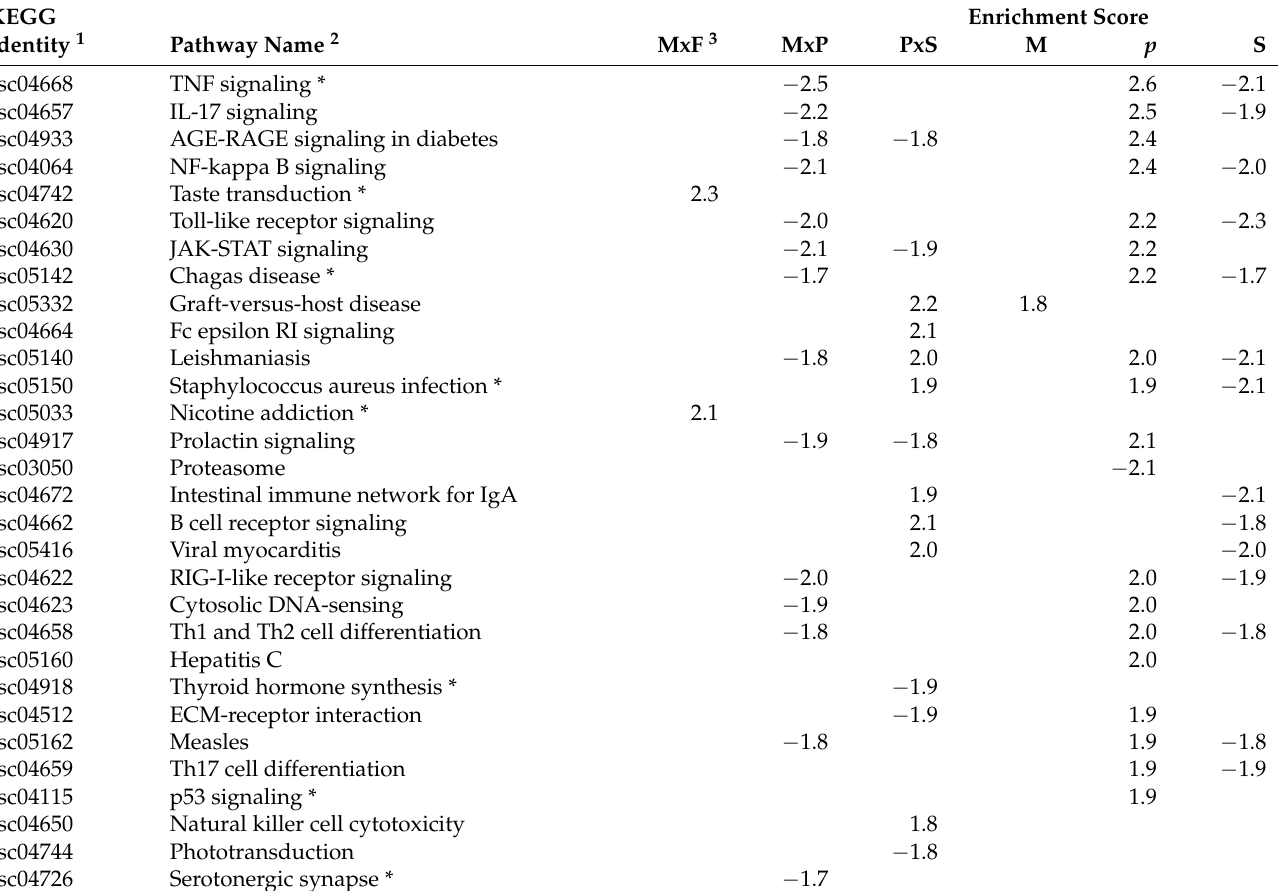
Table 2. Enriched (False Discovery Rate -adjusted p -value < 0.05) Kyoto Encyclopedia of Genes and Genomes (KEGG) pathways identified using the Gene Set Enrichment Analysis (GSEA) among genes presenting high expression changes associated with maternal immune activation (M), postnatal stress of Poly(I:C) ( p ) or fasting (F), sex (S), or interaction effects in the